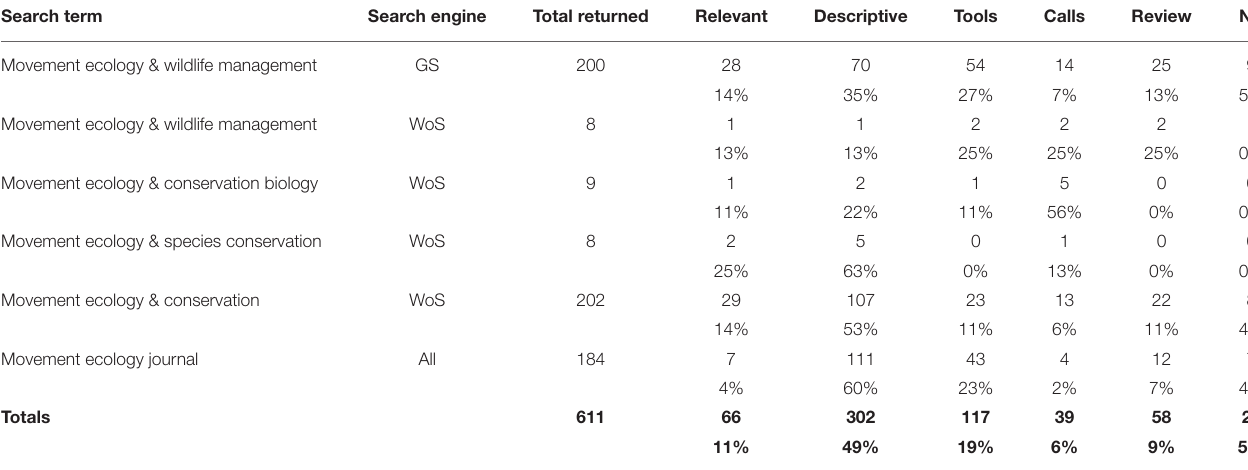
TABLE 3 | Results from six literature searches to assess the degree to which modern movement ecology principles are integrated into conservation biology. Search